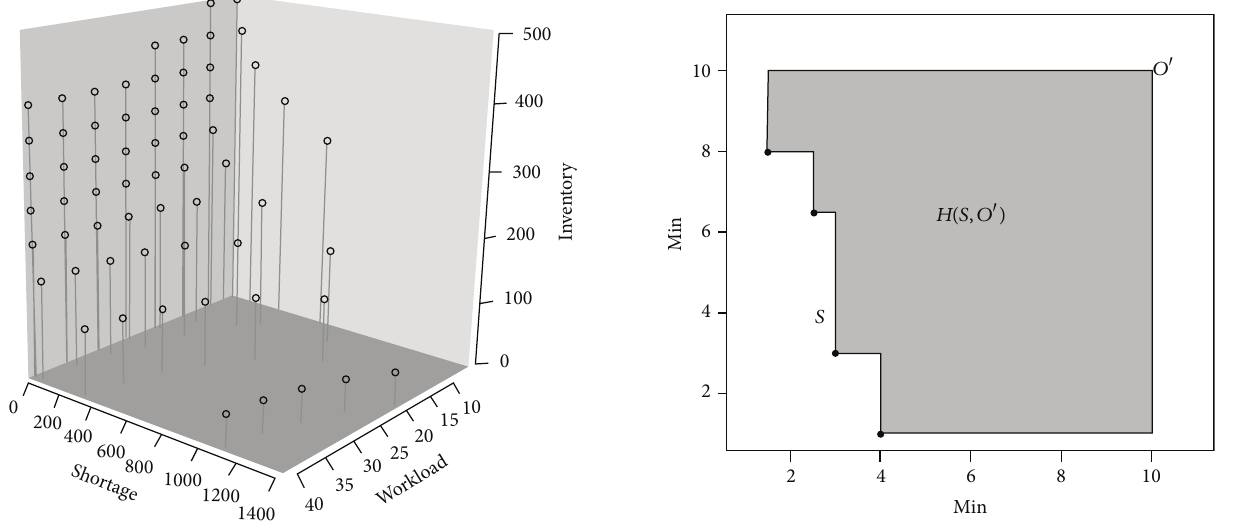
Figure 5: Scatterplot of Item 3 nondominated solutions from successive approximation.